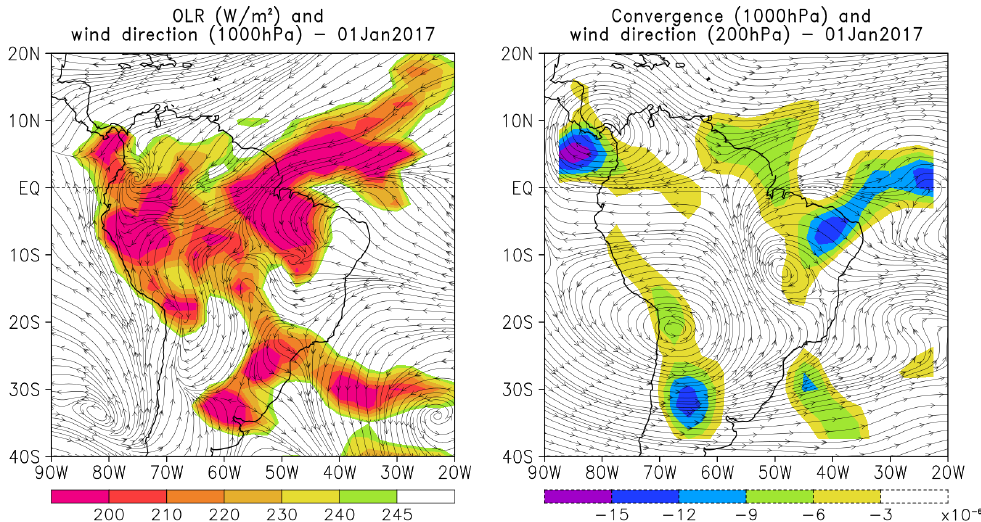
Figure 4. First panel : average daily OLR fields (shaded) and horizontal wind current at 1000 hPa (streamlines). Second panel : wind convergence at 1000 hPa (shaded) and horizontal wind at 200 hPa (streamlines). Both figures correspond to 1 January